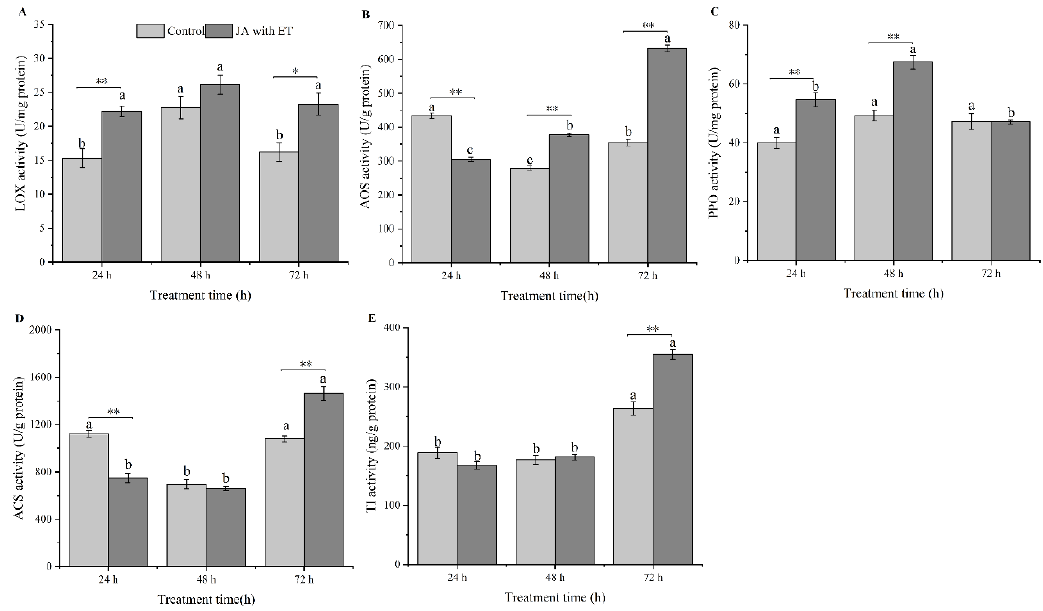
Figure 4. Effect of combined jasmonic acid and ethylene (JA with ET) treatment on the activities of defense enzymes in faba bean plants. ( A ), lipoxygenase (LOX); ( B ), allene oxide synthase (AOS); ( C ), polyphenol oxidase (PPO); ( D ), 1-aminocyclopropane 1-carboxylic acid synthase (ACS); ( E ) trypsin inhibitor (TI). Data are presented as mean ± standard error (n = 4). Different small letters above the bars show significant differences at the 0.05 level among different time points of the same treatment (Tukey multiple range test). “*” and “**” indicate significant differences at the 0.05 and 0.01 levels between different treatments at the same time point.